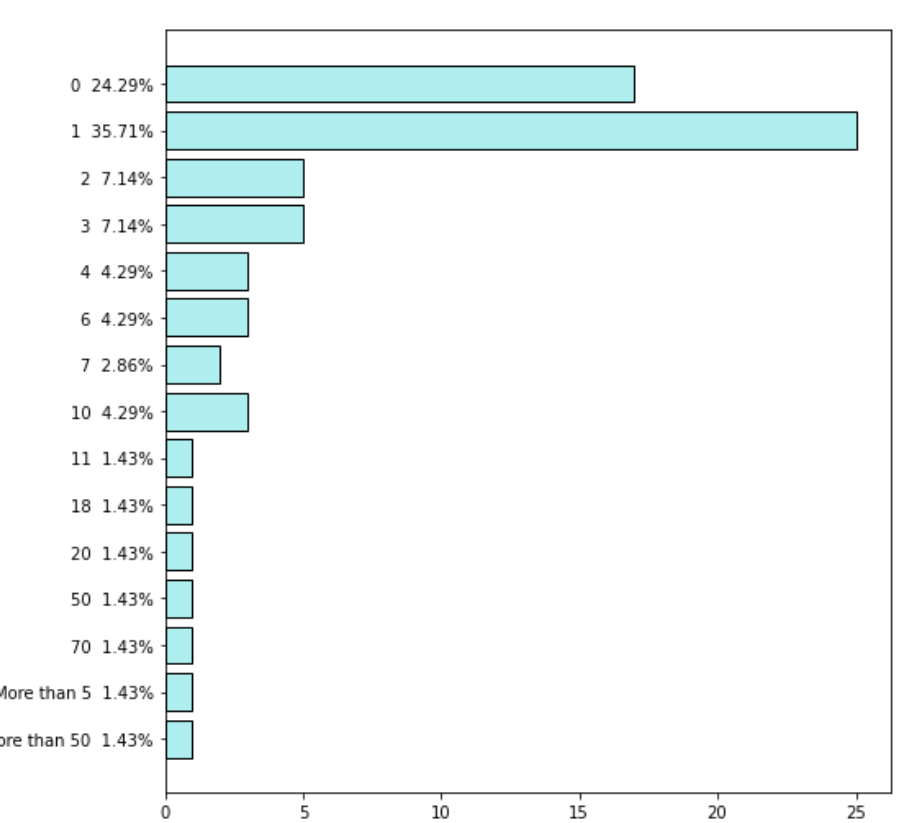
Figure 6. Number of production sites.